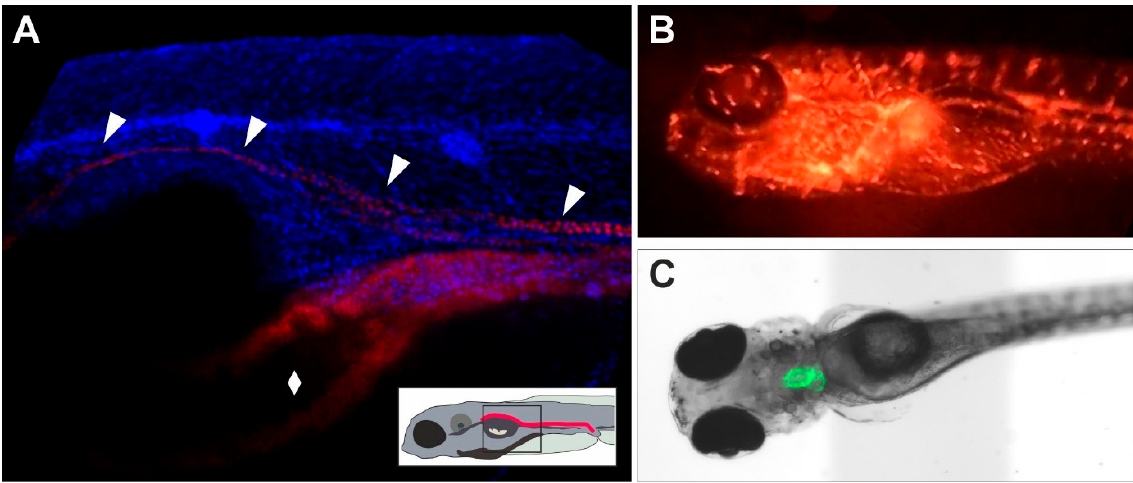
Figure 2. Transgenic zebrafish reporter lines. ( A ) Lateral view of the trunk of a cdh17:mCherry larva (5 dpf), co-stained nuclei with Hoechst 33342. The mCherry fluorescence labels the kidney (arrowheads) and the intestine (diamond). ( B ) Snapshot of a gata1:DsRed larva (5 dpf) in lateral position. Hematopoietic cells are marked by red fluorescence throughout the whole body. ( C ) Ventral gfp /brightfield overlay image of the larval myl7:GFP heart (5 dpf), exhibiting green fluorescence in myocardial cells around the heart chambers (atrium and ventricle) and in the atrioventricular canal.